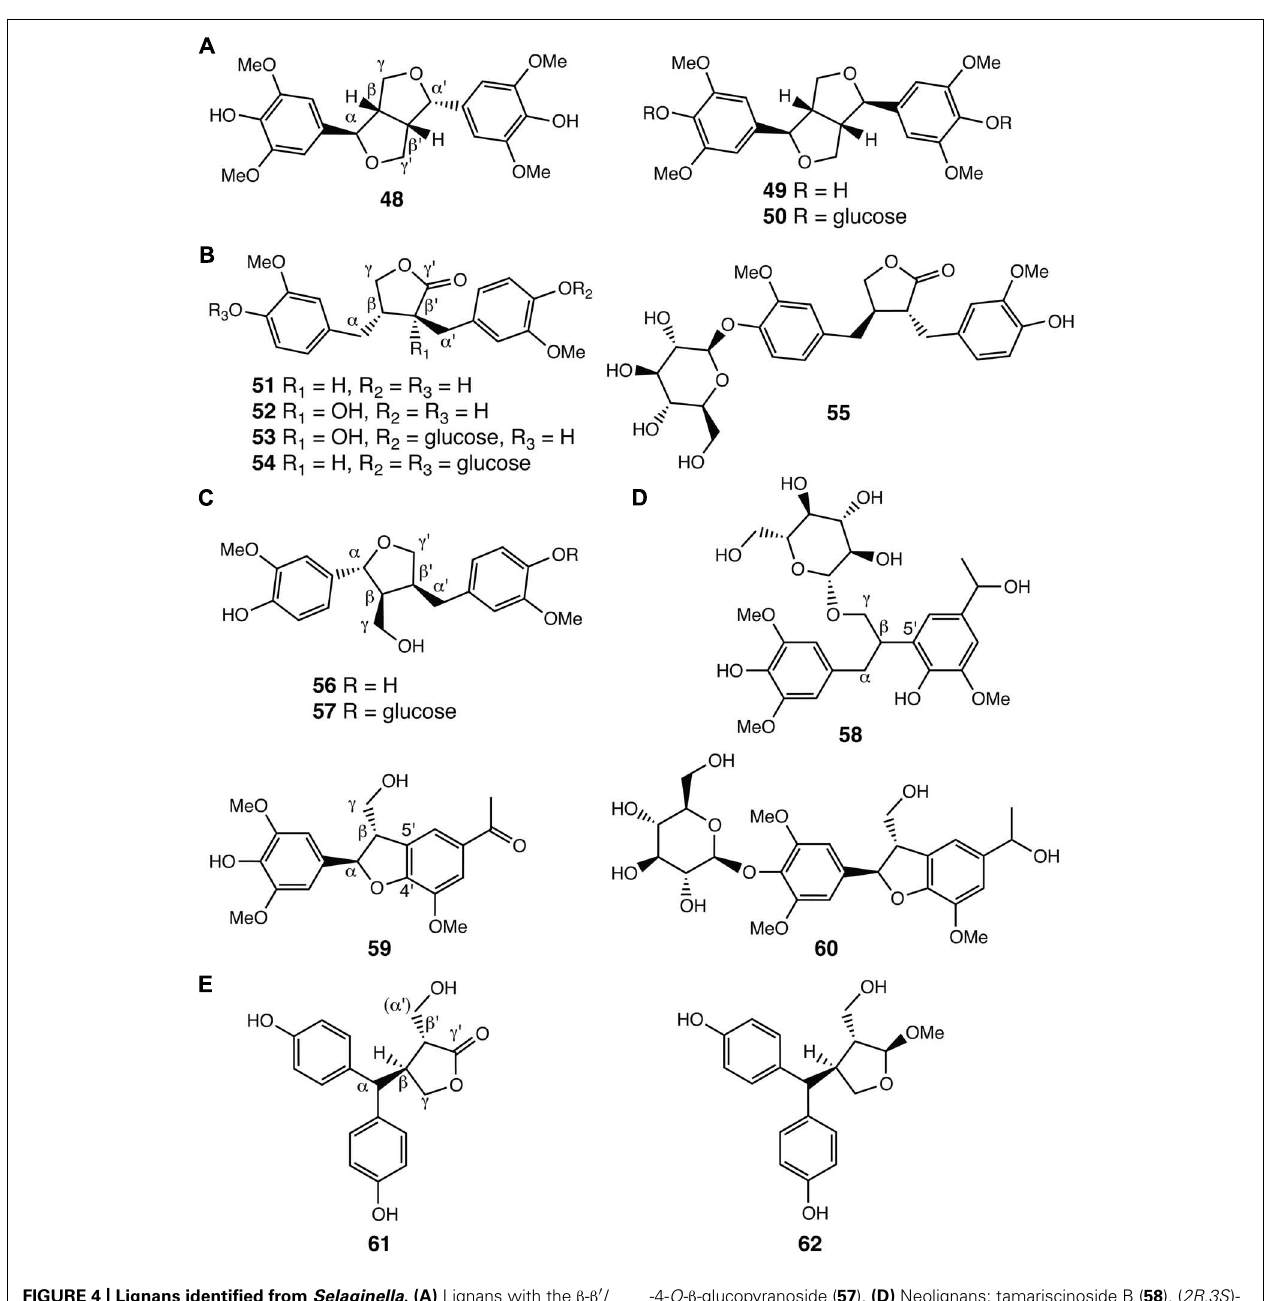
FIGURE 4 | Lignans identified from Selaginella . (A) Lignans with the β - β (cid:2) / γ - O - α (cid:2) / α - O - γ (cid:2) linkage: ( − )-lirioresinol A ( 48 ), ( + )-syringaresinol ( 49 ), ( + )-syringaresinol-4,4 (cid:2) -di- O - β - D -glucopyranoside ( 50 ). (B) Lignans with the β - β (cid:2) / γ - O - γ (cid:2) linkage: matairesinol ( 51 ), wikstromol ( 52 ), notracheloside ( 53 ), matairesinol-4,4 (cid:2) -di- O - β - D -glucopyranoside ( 54 ), styraxlignolide D ( 55 ). (C) Lignans with the β - β (cid:2) / α - O - γ (cid:2) linkage:lariciresinol ( 56 ), lariciresinol